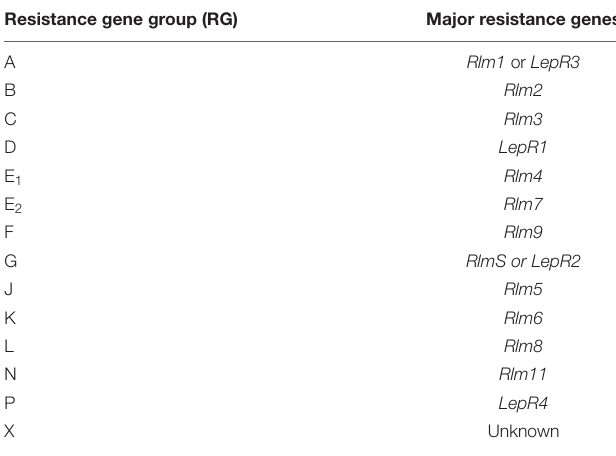
TABLE 1 | The Canadian blackleg major resistance gene labeling system that classifies Brassica napus cultivars’ major resistance genes by lettered resistance gene groups